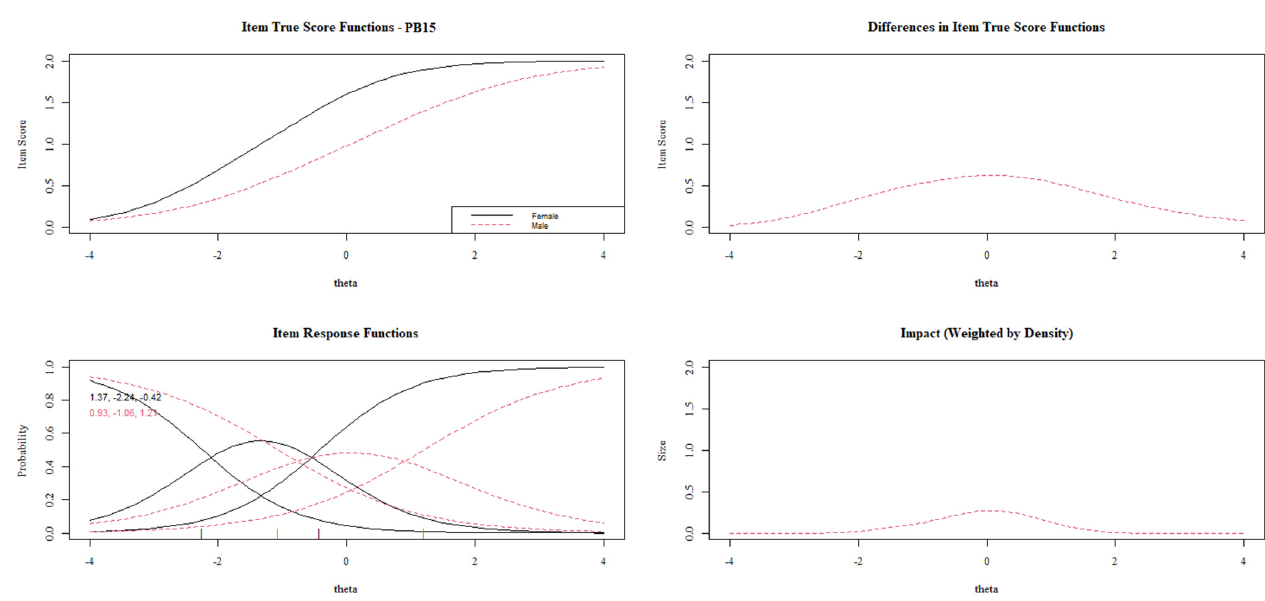
Figure 7. DIF plots for item PB15.